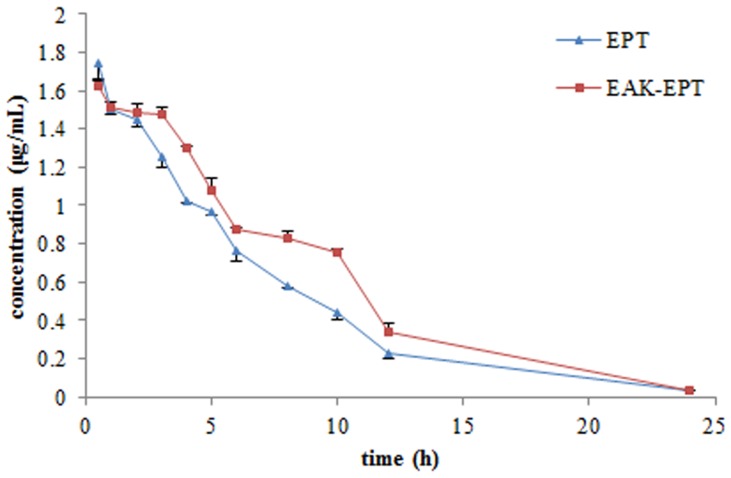
Mean plasma concentration-time profiles of EPT in SD rats (n = 6) after single intravenous injection of EPT and EAK-EPT at a dose of 20 mg of EPT per kg of body weight.